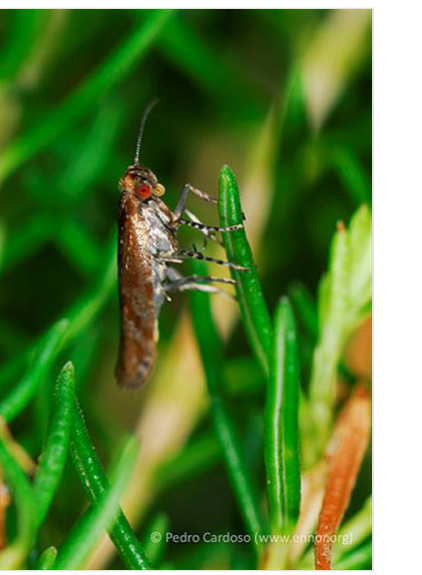
Figure 7. The opilion Leiobunum blackwalli (Credit: Paulo A.V. Borges).